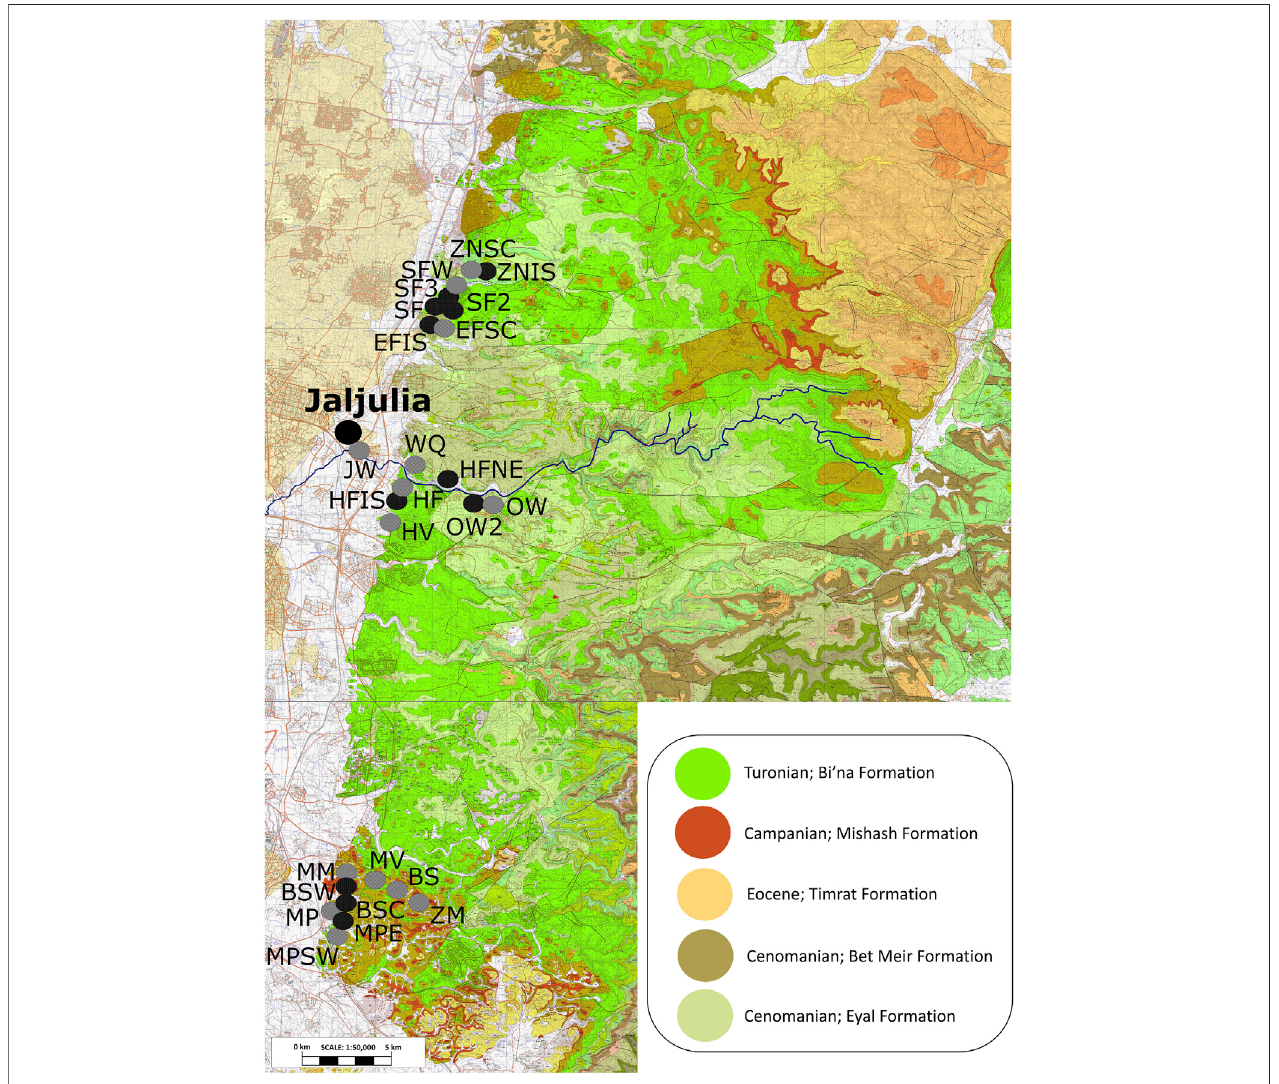
FIGURE 2 | The geologic setting of Jaljulia, and the potential geologic fl int sources located ( Table 4 ). Primary sources are marked by dark circles; secondary sourcesare marked by light grey circles. Note Wadi Qanah and its tributaries, marked by a dark blue line, running from east to west.